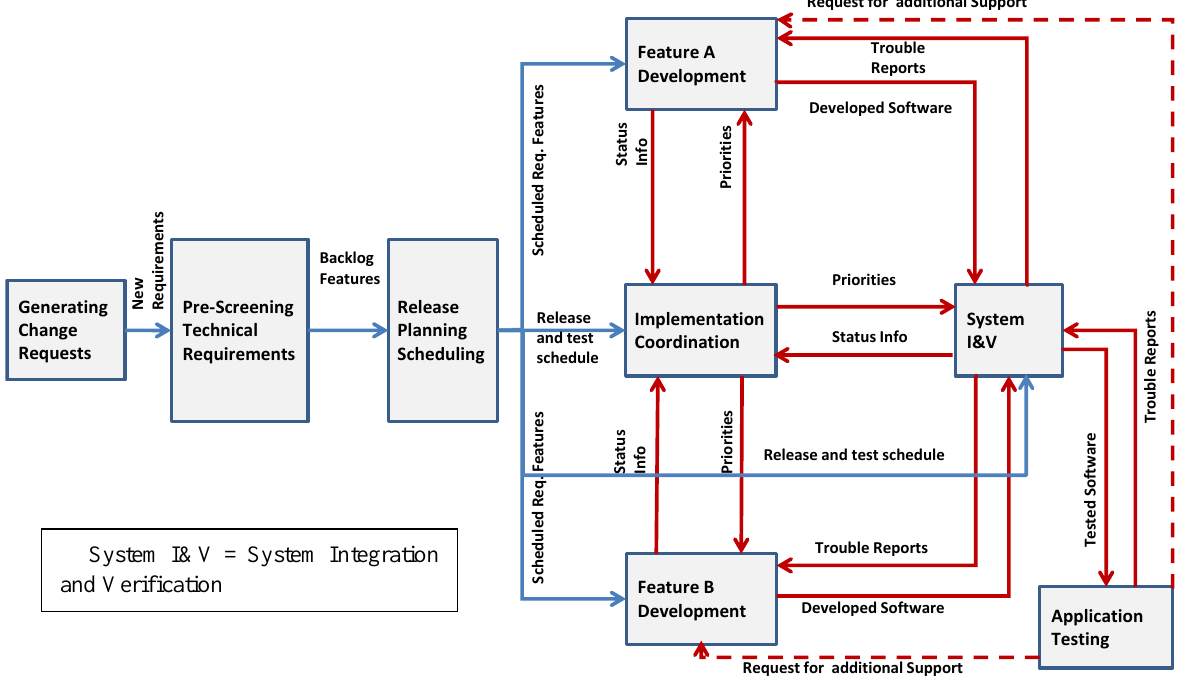
Figure 5. System view with output-input